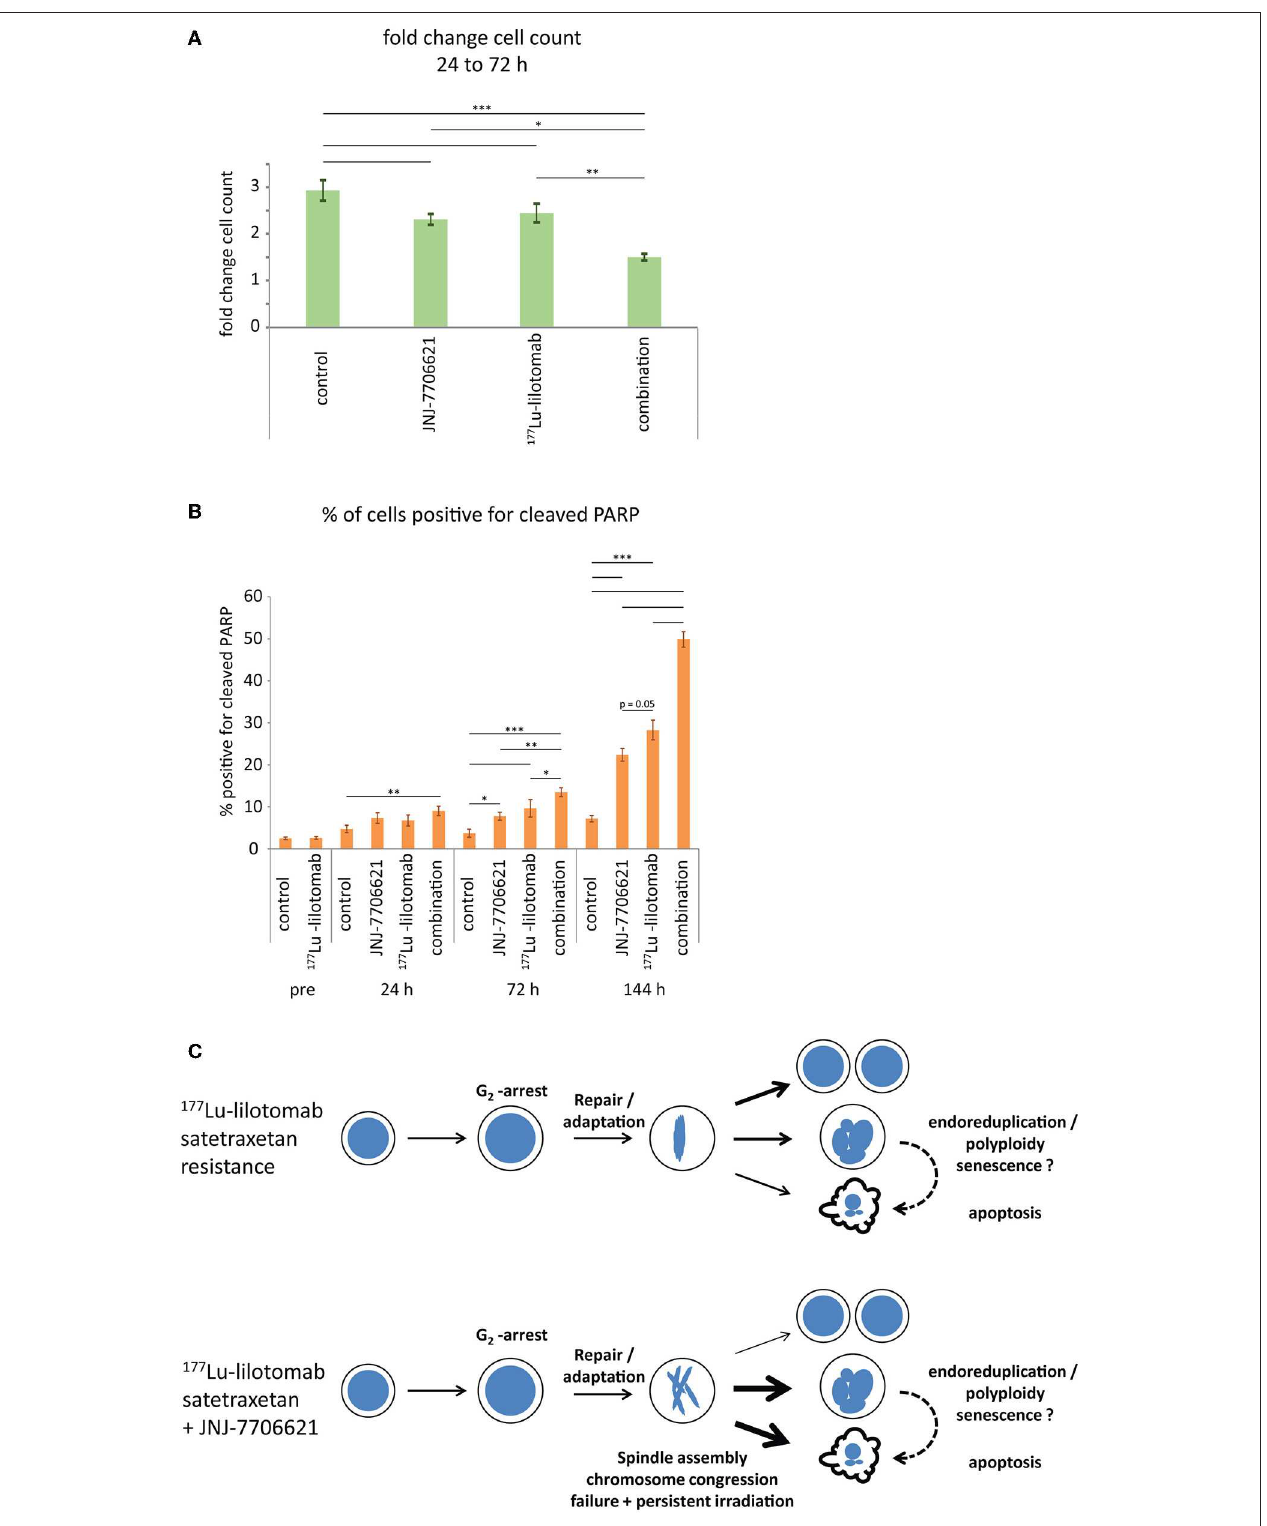
FIGURE 7 | Combined treatment with 177 Lu-lilotomab satetraxetan and JNJ-7706621 induces growth delay and apoptotic death. Cells were treated as in Figure 5 . (A) Bar diagram showing relative cell growth of cells between 24 and 72h after treatment ( n = 4; error bars represent standard error of the mean). (B) Bar